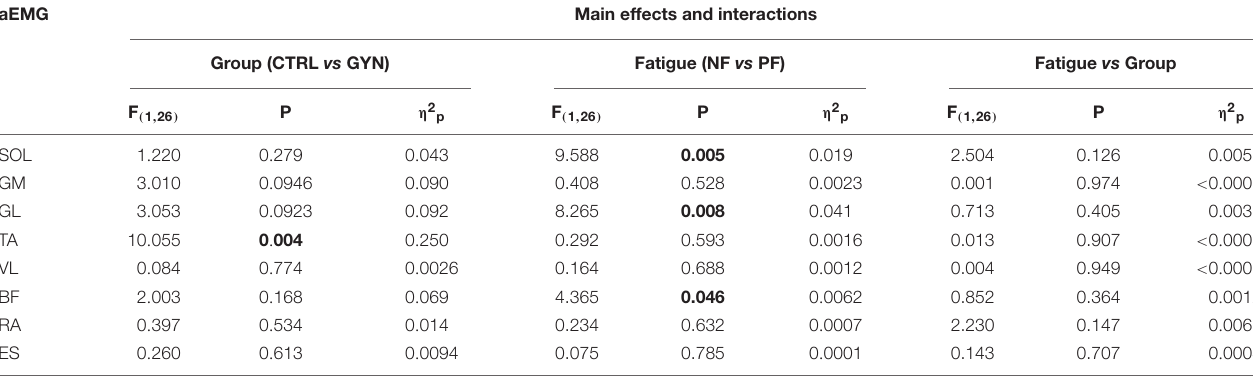
TABLE 3 | Statistical results of the two-way ANOVAs applied to the measurements of the amplitude of the EMG signal (aEMG) before and after the fatiguing protocol. aEMG Main effects and interactions Group (CTRL vs GYN) Fatigue (NF vs PF) Fatigue vs